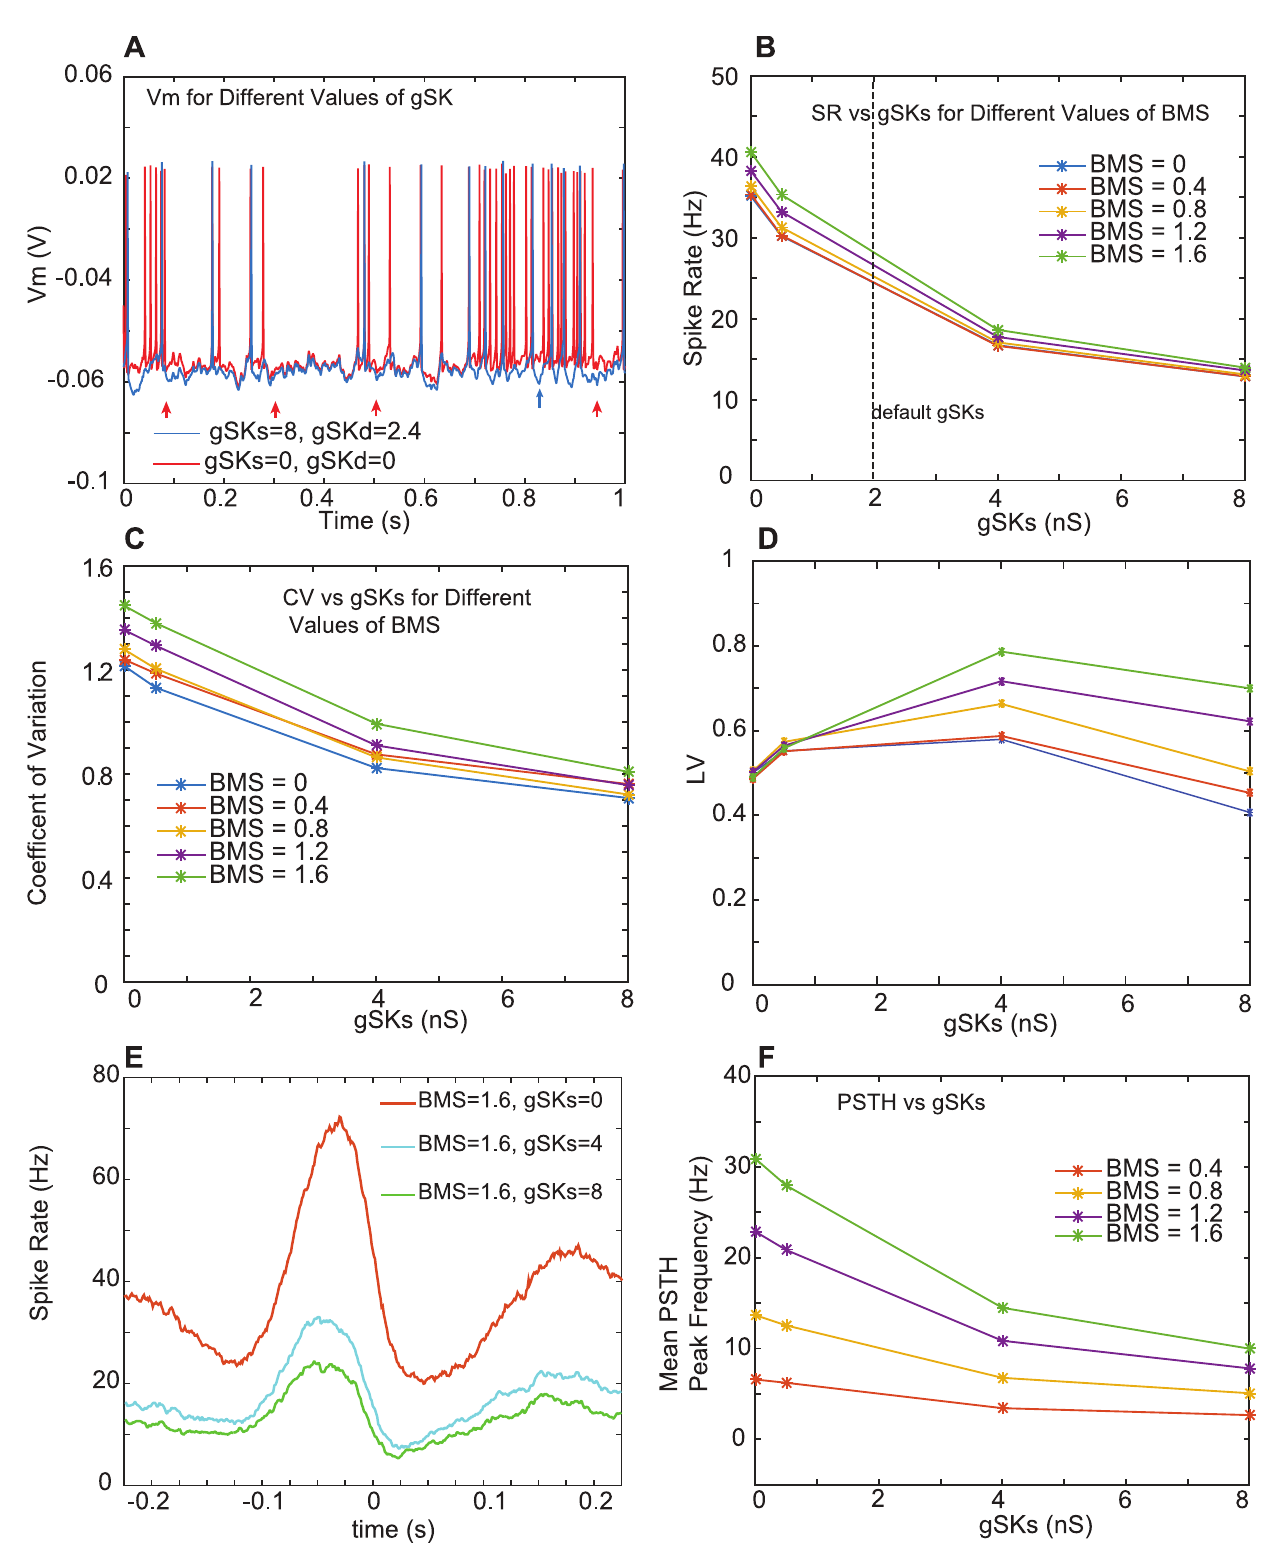
Fig 8. Effect of SK conductance density on model output. A. Sample periodof spikingfor zero (red trace) and 8 nS (blue trace) somatic gSk. Red arrows point to respiratory event times. Blue arrow points to a sample spike afterhyperpolarization(AHP), showingincreasedAHP